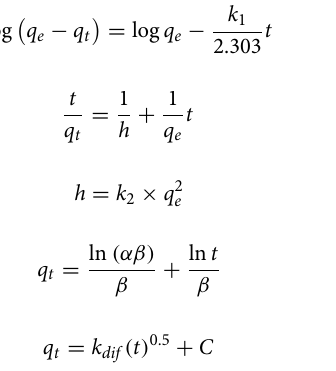
Adsorption studies. Sample solution pH. The effect of sample solution pH was investigated between 5.0 and 9.0. Lower pHs were not studied because of the instability of the dye 36 . 5.0 mL of the standard solution of CR (50 mg L −1 ) and an adsorbent amount of 10.0 mg were used (298 K, 2 h, 1500 rpm). As Fig. 6a shows, the removal efficiency was firstly decreased with increasing the solution pH and then slightly increased. The decrease in the removal efficiency is may be related to this phenomenon that the surface of the material becomes less positive when pH enhanced from 5.0 to 7.0. Based on the results, pH = 5.0 was chosen. Adsorbent amount. Various adsorbent amounts between 1.0 and 20.0 mg were tested. A dye concentration of 50 mg L −1 (pH = 5.0) was adopted (298 K, 2 h, 1500 rpm). The removal efficiency was first increased by enhancing the adsorbent dosage, and then no significant increase was observed in the case of all nanocomposites (Fig. 6b). Finally, 10.0 mg of each adsorbent was chosen. Contact time. Contact times in the range of 10 and 240 min were tested to investigate the effect of time on the adsorption process. Standard solutions of CR (50 mg L −1 , pH = 5.0) with an adsorbent amount of 10.0 mg were used (298 K). As Fig. 6c shows, an increase in removal efficiency occurred for all three nanocomposites when the stirring time was enhanced from 10 to 180 min. A time of 180 min was chosen for further experiments. The kinetic studies. In this step, four kinetic models including pseudo-first-order (PFO, Eq. 3), pseudo-second- order (PSO, Eqs. 4, 5), Elovich (Eq. 6), and intra-particle diffusion (IPD, Eq. 7) were used to study the mecha- nism of adsorption. In the following equations, q e and q t (mg g −1 ) are the capacity of adsorption at equilibrium condition and at time t, k 1 (min −1 ) is PFO rate constant, h (mg g −1 min −1 ) is the initial sorption rate in PSO, k 2 (g mg -1 min −1 ) is PSO rate constant, α (mg g −1 min −1 ) & β (g mg −1 ) are Elovich constants, k dif (mg g −1 min −0.5 ) is the IPD rate constant. Also, C (mg g −1 ) is a constant. The obtained results are shown in Fig. 7 and Table 2. For all three nanocomposites, the PSO and IPD kinetic models provided the best results regarding the R 2 value (a physiochemical process) with an intraparticle diffusion mechanism. The obtained R 2 values for the PSO model were 0.9909, 0.9926, and 0.9906 for NC-1%, NC-3%, and NC-5%, respectively. Also, the obtained R 2 values for IPD model were 0.9863, 0.9939, and 0.9918 for NC-1%, NC-3%, and NC-5%, respectively.